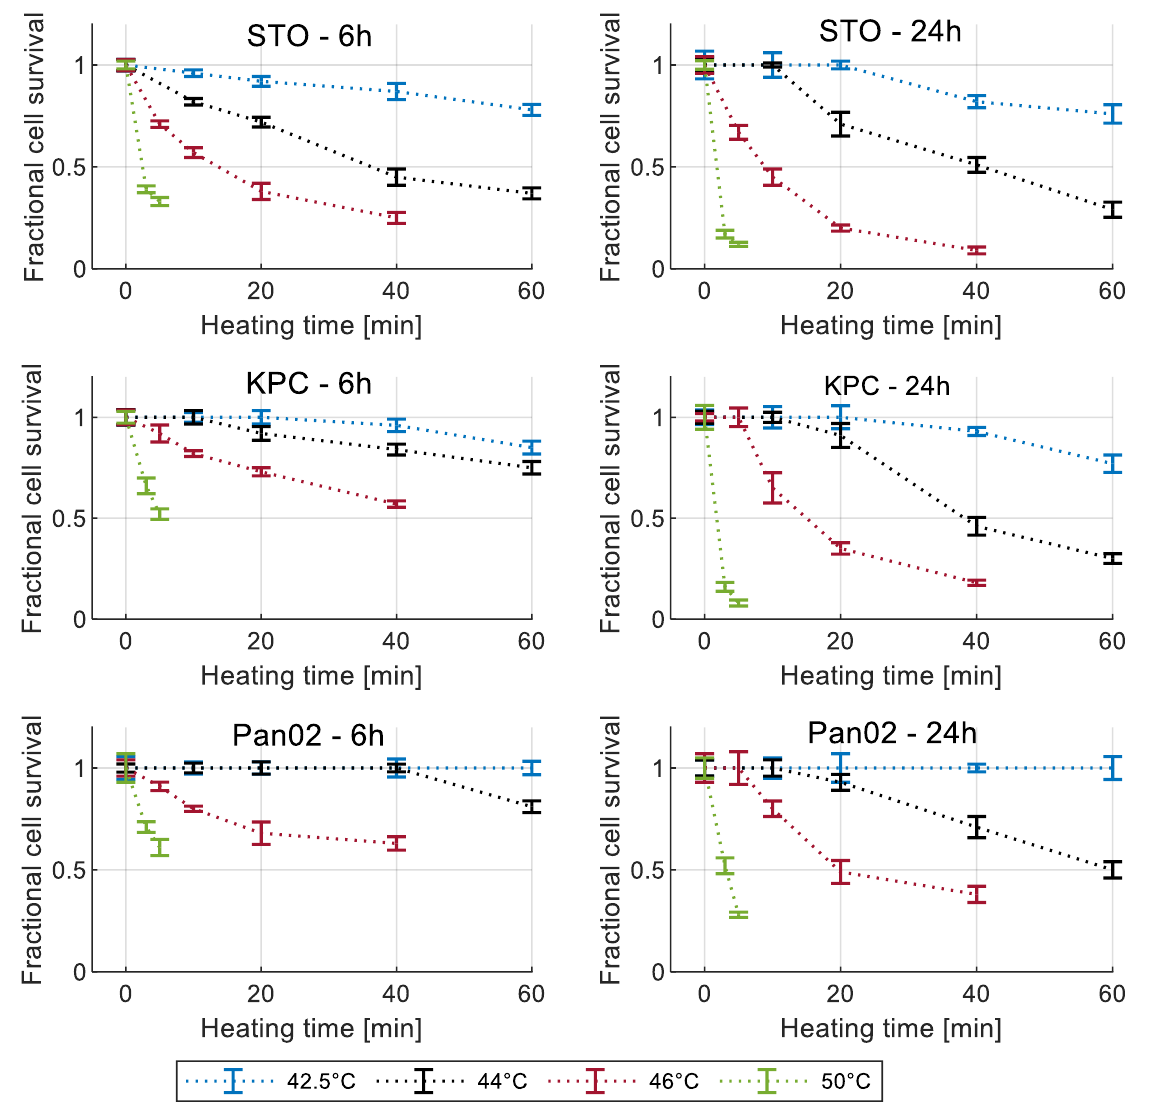
Figure 3. Measured cell viability for all three cell lines normalized to 37 °C control for different recovery times. Error bars represent one standard deviation.